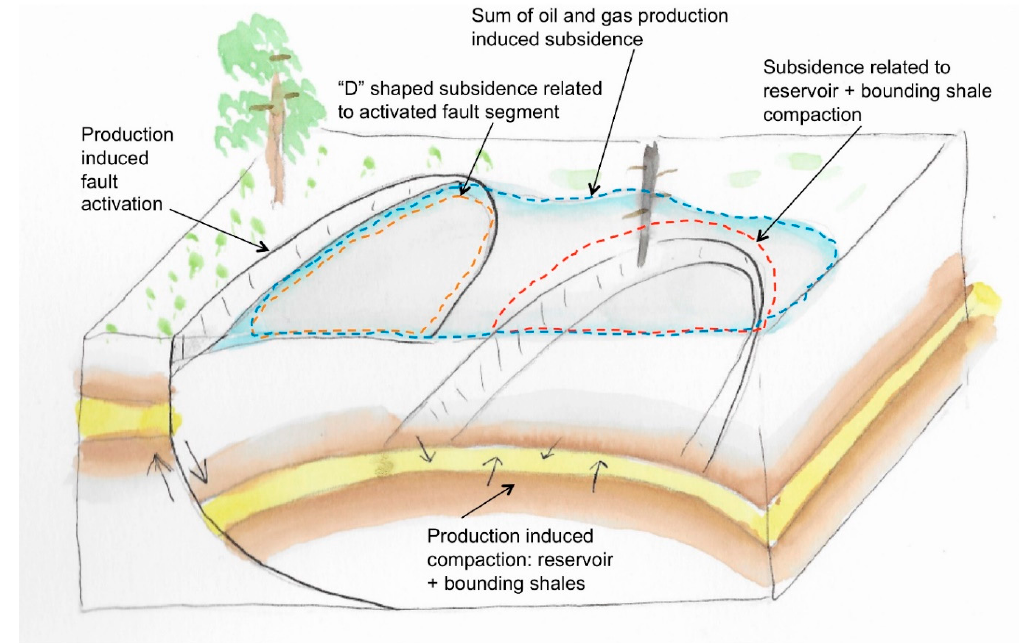
Figure 13. Typical Mississippi River Delta oil and gas reservoir, a rollover anticline on the downthrown side of a down-to-the-coast normal fault. Oil, gas, and water production affects the subsurface in and around the producing reservoir. The depletion process leads to production induced fault activation, reservoir compaction with additional compaction of bounding shales as shown in the subsurface. The surface manifestation of these subsurface changes is shown as a composite of land loss on the downthrown side the activated fault plus subsidence over the compacted oil, gas, and water producing reservoir.